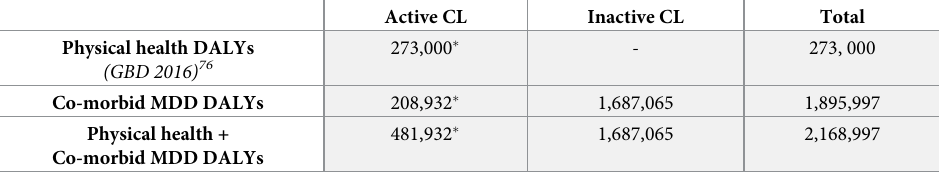
Table 8. Overall DALY estimates for cutaneous leishmaniasis (aCL and